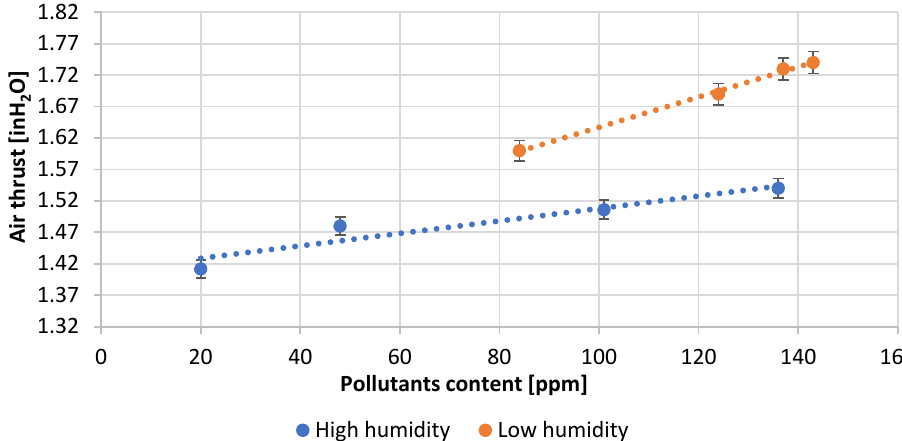
Figure 6. Dependence of air draft in reactor on pollutants content.